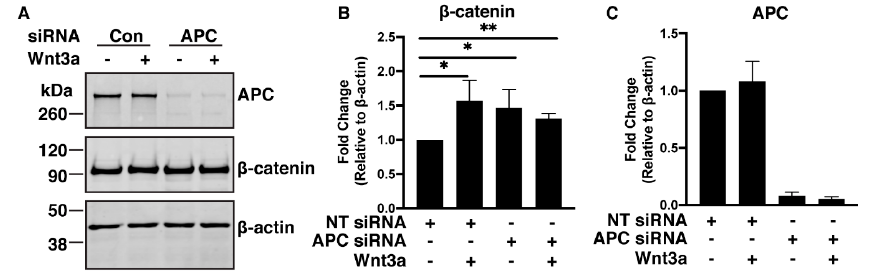
Figure 3. β -cat ∆ S45 accumulates upon Wnt-3a treatment or APC-depletion. ( A ) Western blot of HCT116 β m cells transfected with control-siRNA or APC-siRNA and treated in the presence or absence of 125 ng Wnt3a. ( B ) Relative fold-change of β -catenin relative to β -actin and normalized to control-siRNA without Wnt. Data averaged from four independent experiments. Error bars, SD; Statistical analysis by t -test: * p < 0.05; ** p < 0.01. ( C ) Quantification of APC fold-change relative to β -actin and normalized to control-siRNA without